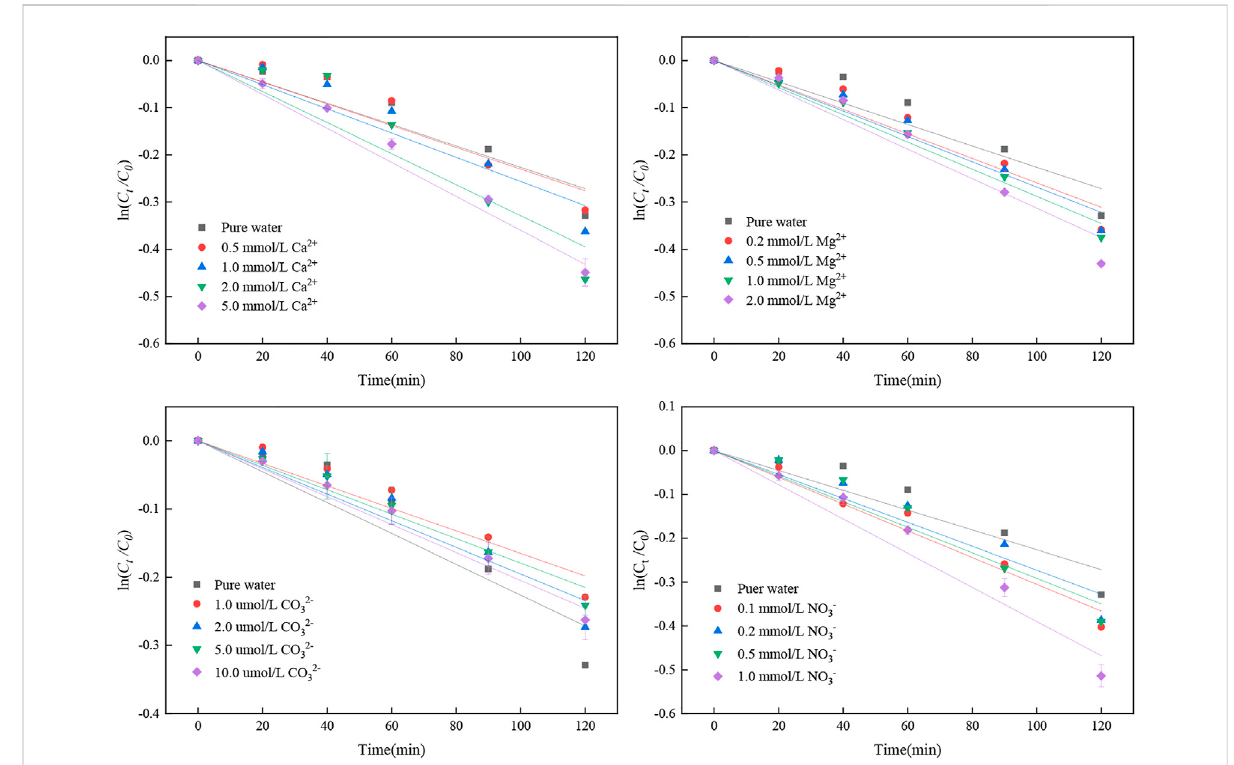
FIGURE 8 Effect of ions concentration on photodegradation of acid orange 8 by